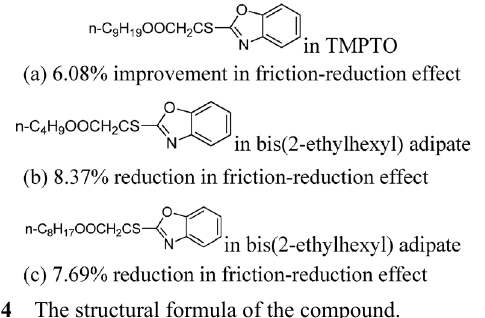
Fig. 34 The structural formula of the compound.